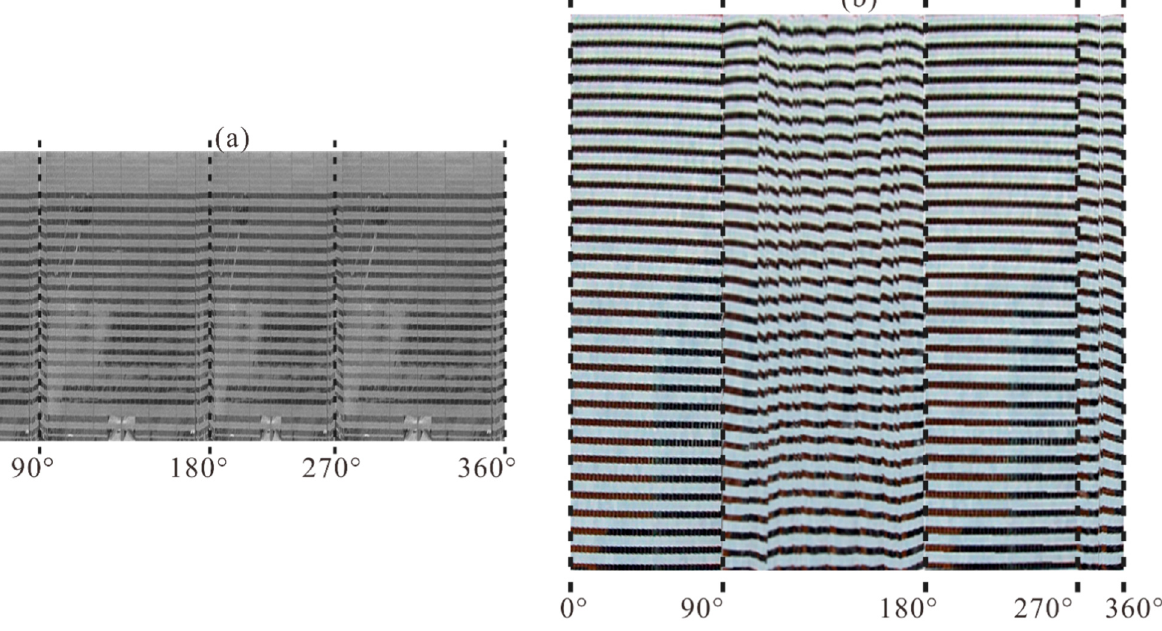
Figure 13. Façade texture orthorectification results. ( a , b ) are the orthorectification results of the building Façade texture in a and c in Figure 12. building Façade texture in a and c in Figure